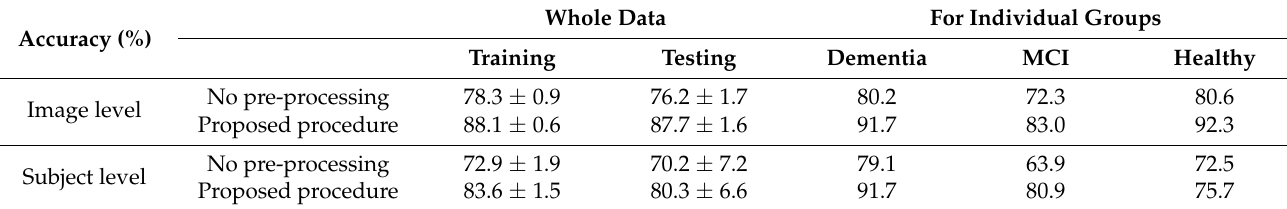
Table 4. Results of an ablation study on the performance of the EPVS rating estimation model with and without pre- processing with the Haar transformation approach (testing and training accuracy is reported as mean ± standard deviation; cross-entropy was used for loss function during